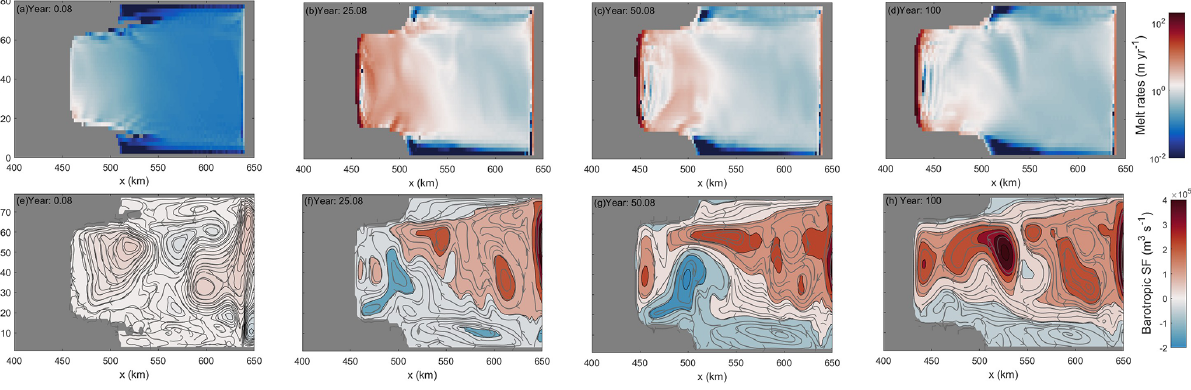
Figure 4. Spatial pattern of basal melting (myr − 1 ) (a–d) and barotropic streamfunction XY sections (m 3 s − 1 ), with circulation contours extracted from the barotropic flow field (e–h) at different years from CTRL.